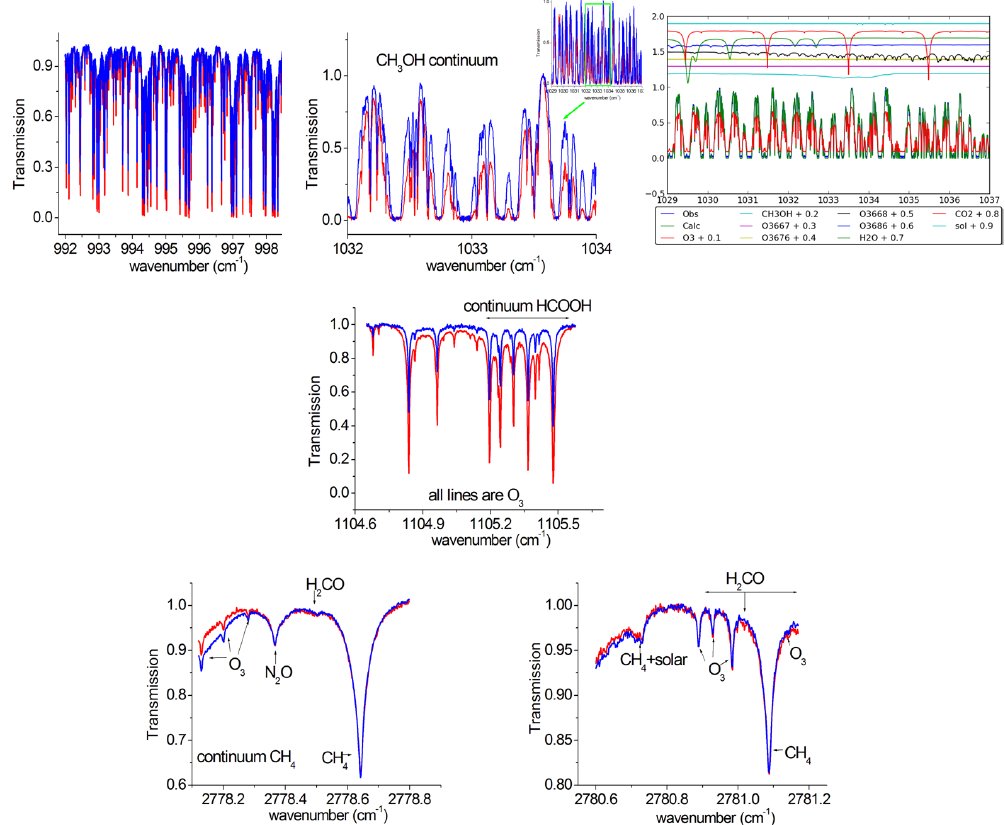
Figure 2. Microwindows used in the retrievals of CH 3 OH, HCOOH and H 2 CO, with examples of clear and polluted conditions in blue and red,